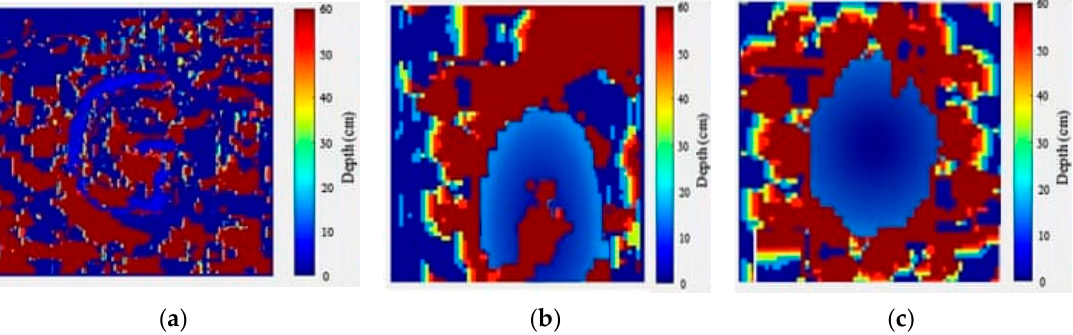
Figure 5. Disparity map acquisition of 3D transparent objects based on single-pixel imaging. ( a ) The depth map of the object “G” is displayed with a disparity range. ( b ) The depth map for the complex object is illustrated with a disparity range. ( c ) The depth map for the object “Transparent-circle”.